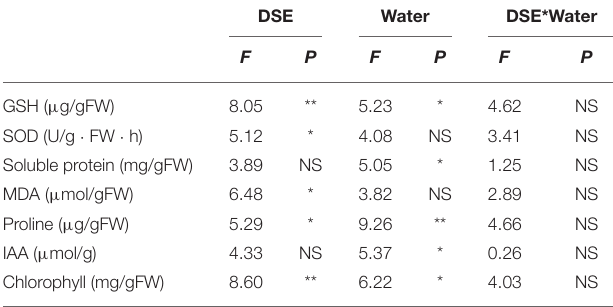
TABLE 3 | Two-way ANOVA of the effect of DSE and water condition on plant physiological parameters of Lycium ruthenicum